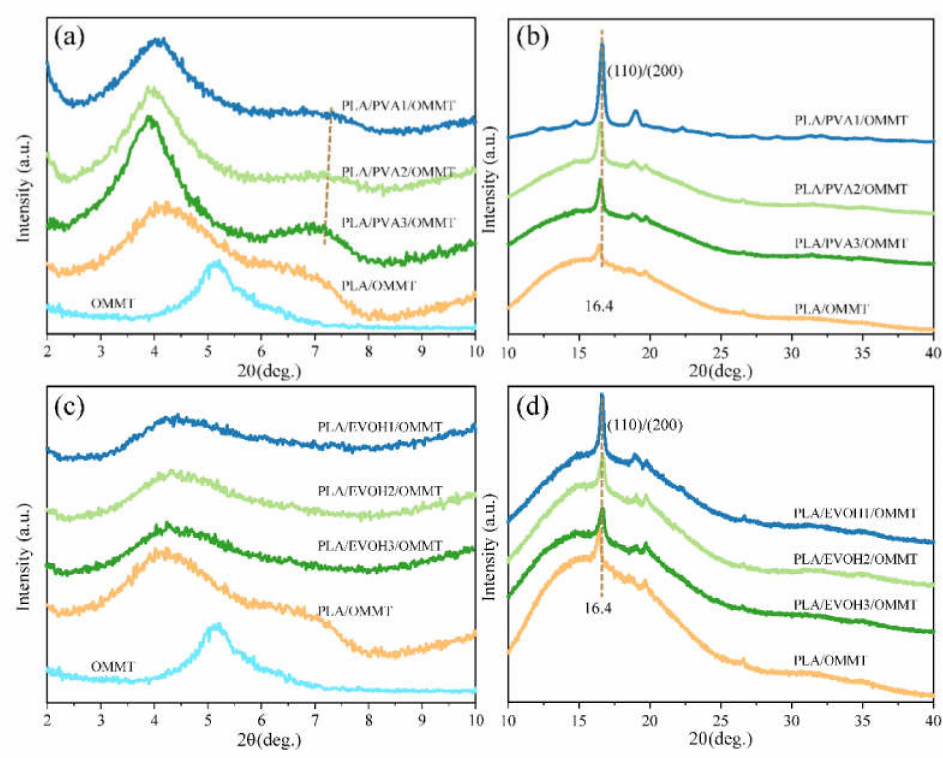
Figure 1. XRD curves of ( a , b ) PLA/PVA/OMMT; ( c , d ) PLA/EVOH/OMMT composite films. Table 2. The 2 θ values and corresponding d -spacing of PLA/PVA/OMMT and PLA/EVOH/OMMT composite films.